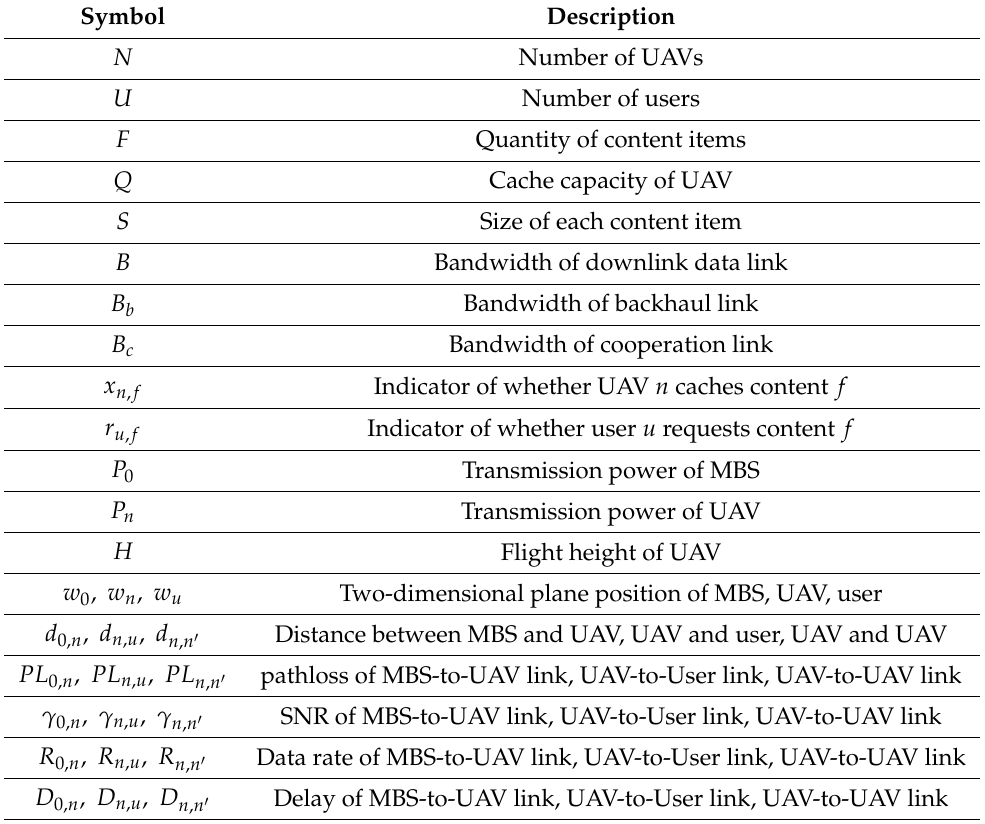
Table 1. Key Variables Used in This